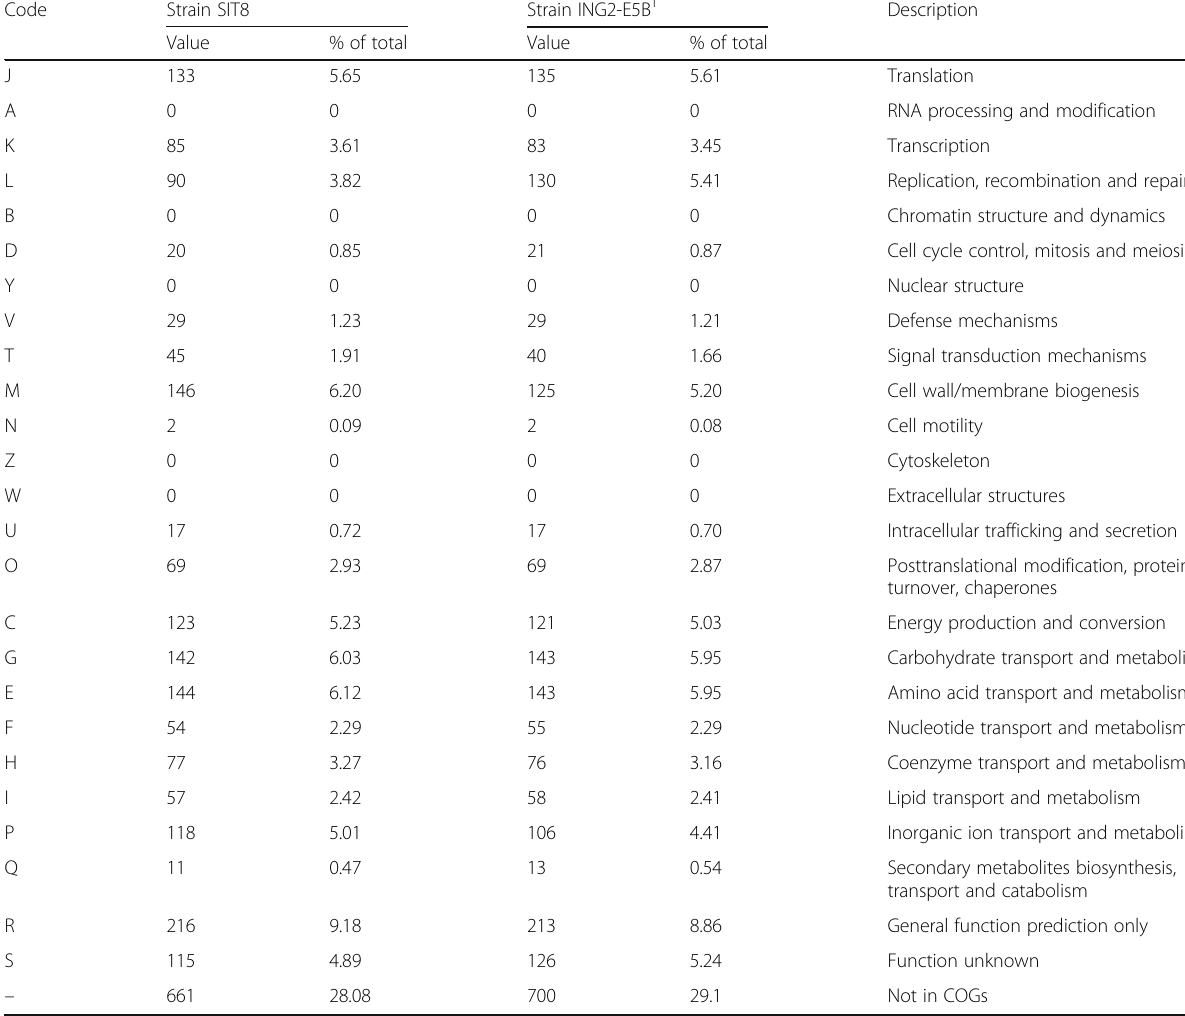
Table 4 Number of genes associated with the 25 general COG functional categories Code Strain